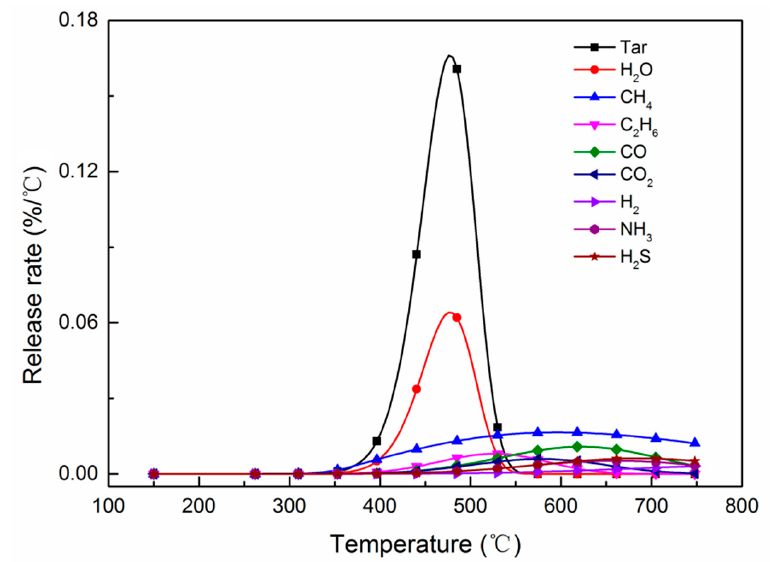
Figure 4. Release rate of tar and H 2 O and the tar yield from the coal particle as a function of temperature ( d = 20 mm).